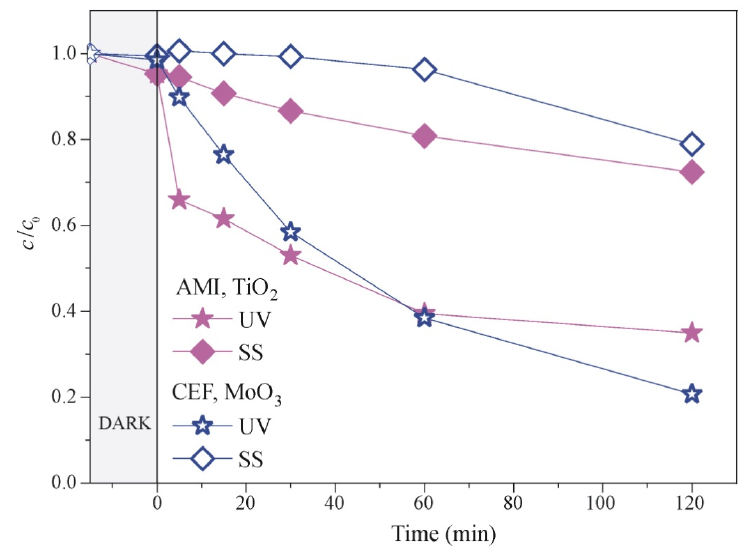
Figure 9. Effect of radiation type on the AMI and CEF (0.05 mmol/dm 3 ) removal using TiO 2 and MoO 3 (1.0 mg/cm 3 ) photocatalysts, respectively, at a natural